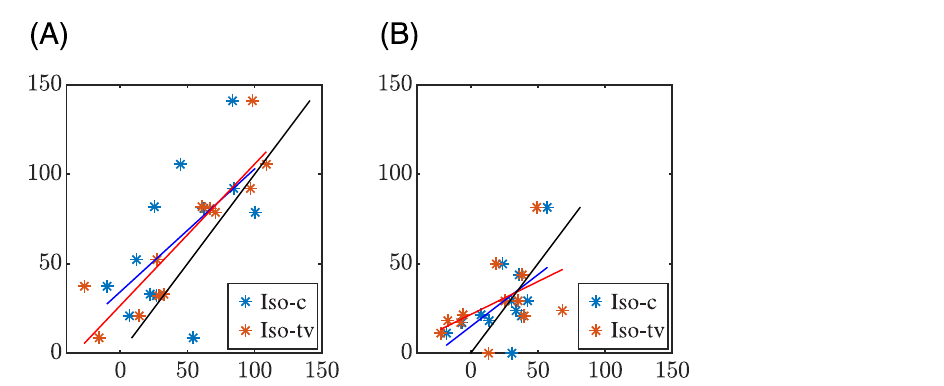
Fig 8. Relationship between the QT adaptation delays calculated using the M estimation strategy in patients (vertical axis, τ φ , p , φ 2 { e , r }) and in simulations (horizontal axis, τ φ , s ) for a constant (blue) or time-varying Iso level (red). Fitted lines are shown in the corresponding colors. The black lines show the diagonal.